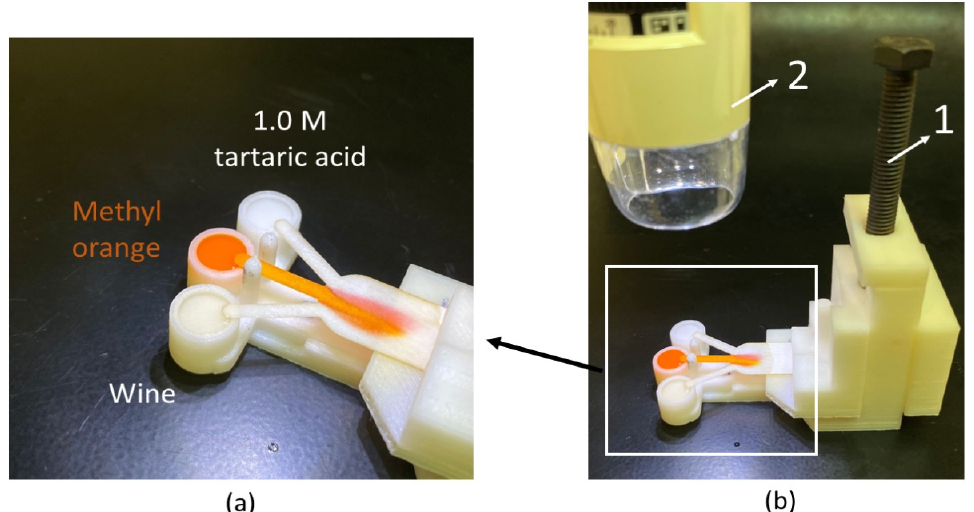
Figure 3. ( a ) Picture of the ionic strength wine evaluation. Each reservoir is filled with 60 µL of solution. ( b ) Picture of a test under performance. Numbers 1 and 2 are the vertically adjustable arm and digital microscope, respectively.